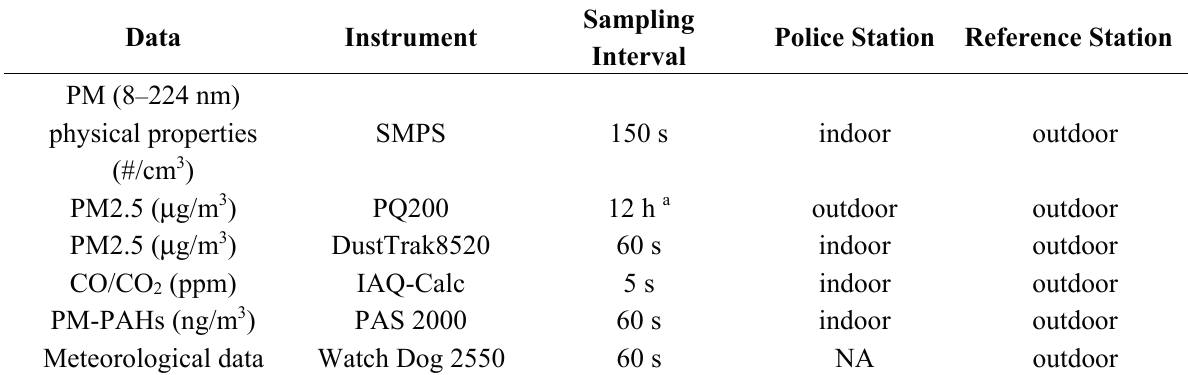
Table 2. Air monitoring instruments and locations.